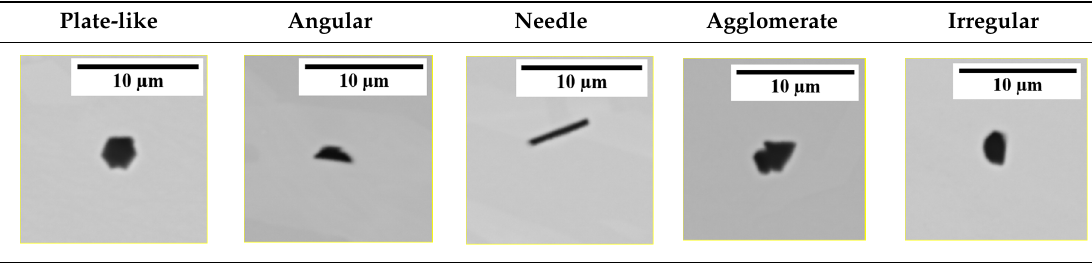
Figure 8. The precipitation ratio (PR) value for AlN on Al 2 O 3(pure) inclusions on 533N-P steels.